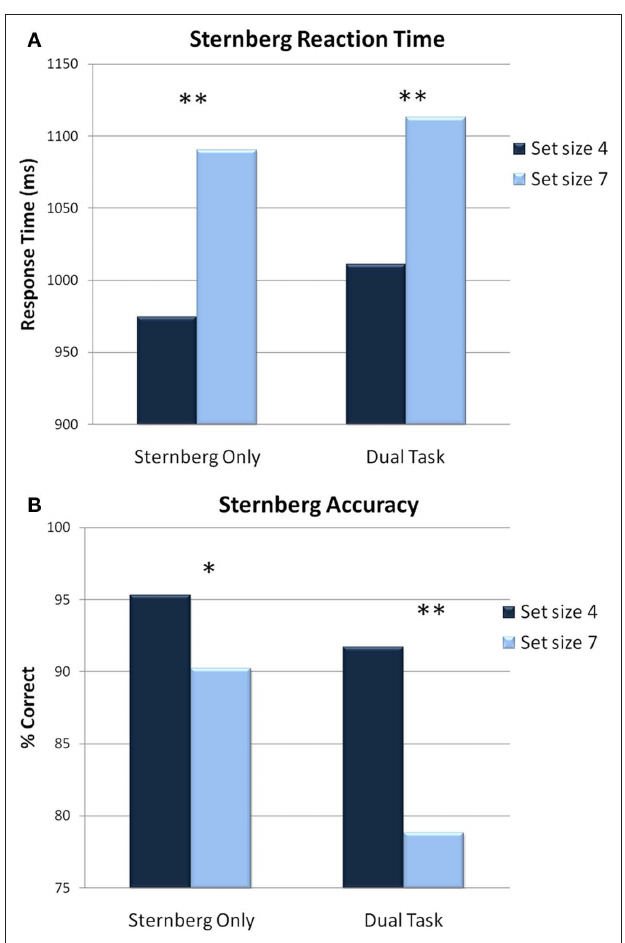
FiguRE 3 | Behavioral results for the Sternberg task. (A) RTs on Sternberg trials for each condition. Participants responded faster to probes from a set size of 4 compared to set size of 7. (B) Accuracy on Sternberg trials for each condition. Accuracy declined to probe items from a set size of 7 compared to a set size of 4. * p < 0.05, ** p